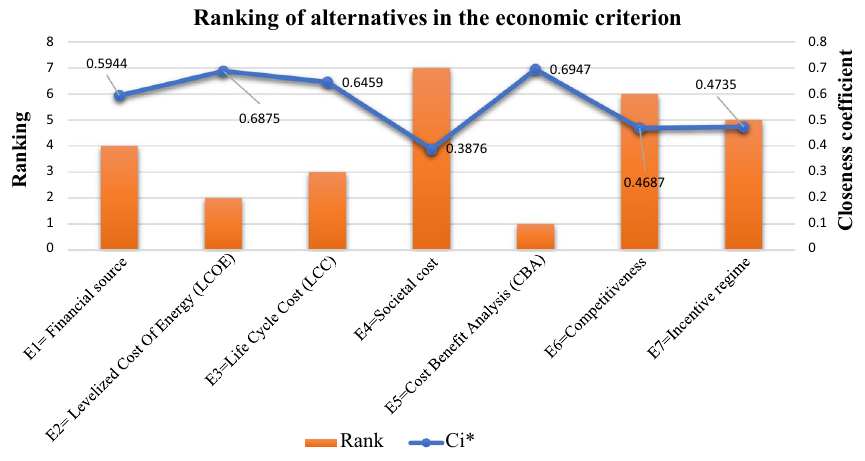
Fig. 14 Ranking of alternatives in the economic